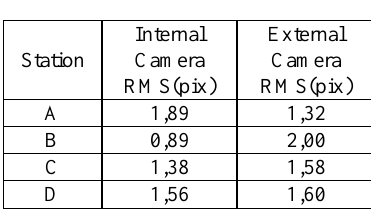
Figure 7. The colored point cloud of station B using the internal camera.